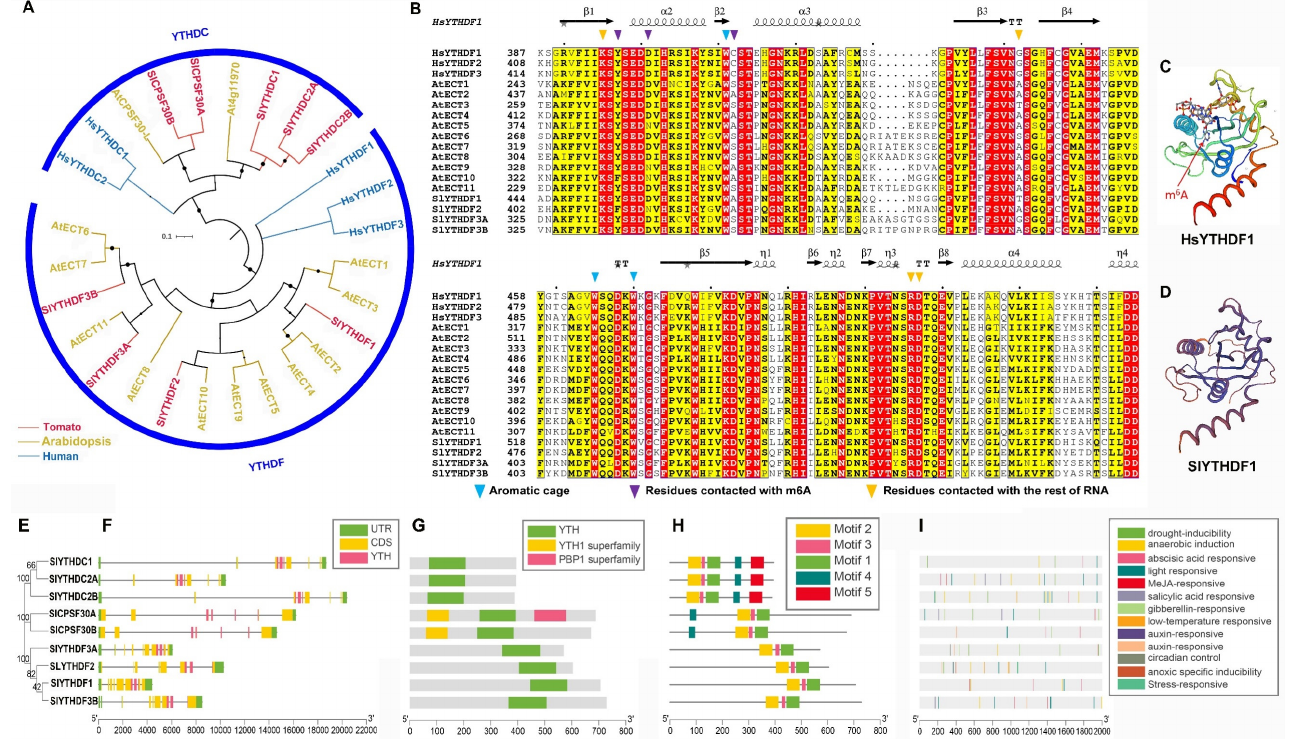
Figure 4. Evolutionary and structure analyses of the YTH family in tomato. ( A ) Phylogenetic tree of YTH family proteins from tomato, Arabidopsis , and human. ( B ) Sequence alignment of YTHDF subfamily proteins from tomato, Arabidopsis , and human. The secondary structural elements in the HsYTHDF1 (PDB: 4rcj) YTH domain are shown above. The colored triangles indicate key functional residues in human. ( C , D ) Three-dimensional structures of HsYTHDF1 and SlYTHDF1. ( E ) Phylogenetic tree of YTH family proteins in tomato. ( F ) Gene structure analysis. The coding sequence (CDS), untranslated region (UTR), and YTH domain are displayed in different colors, and the lines between boxes represent introns. ( G , H ) Conserved domain and motif analysis. ( I ) Locations of cis-elements in the 2kb promoter sequences.